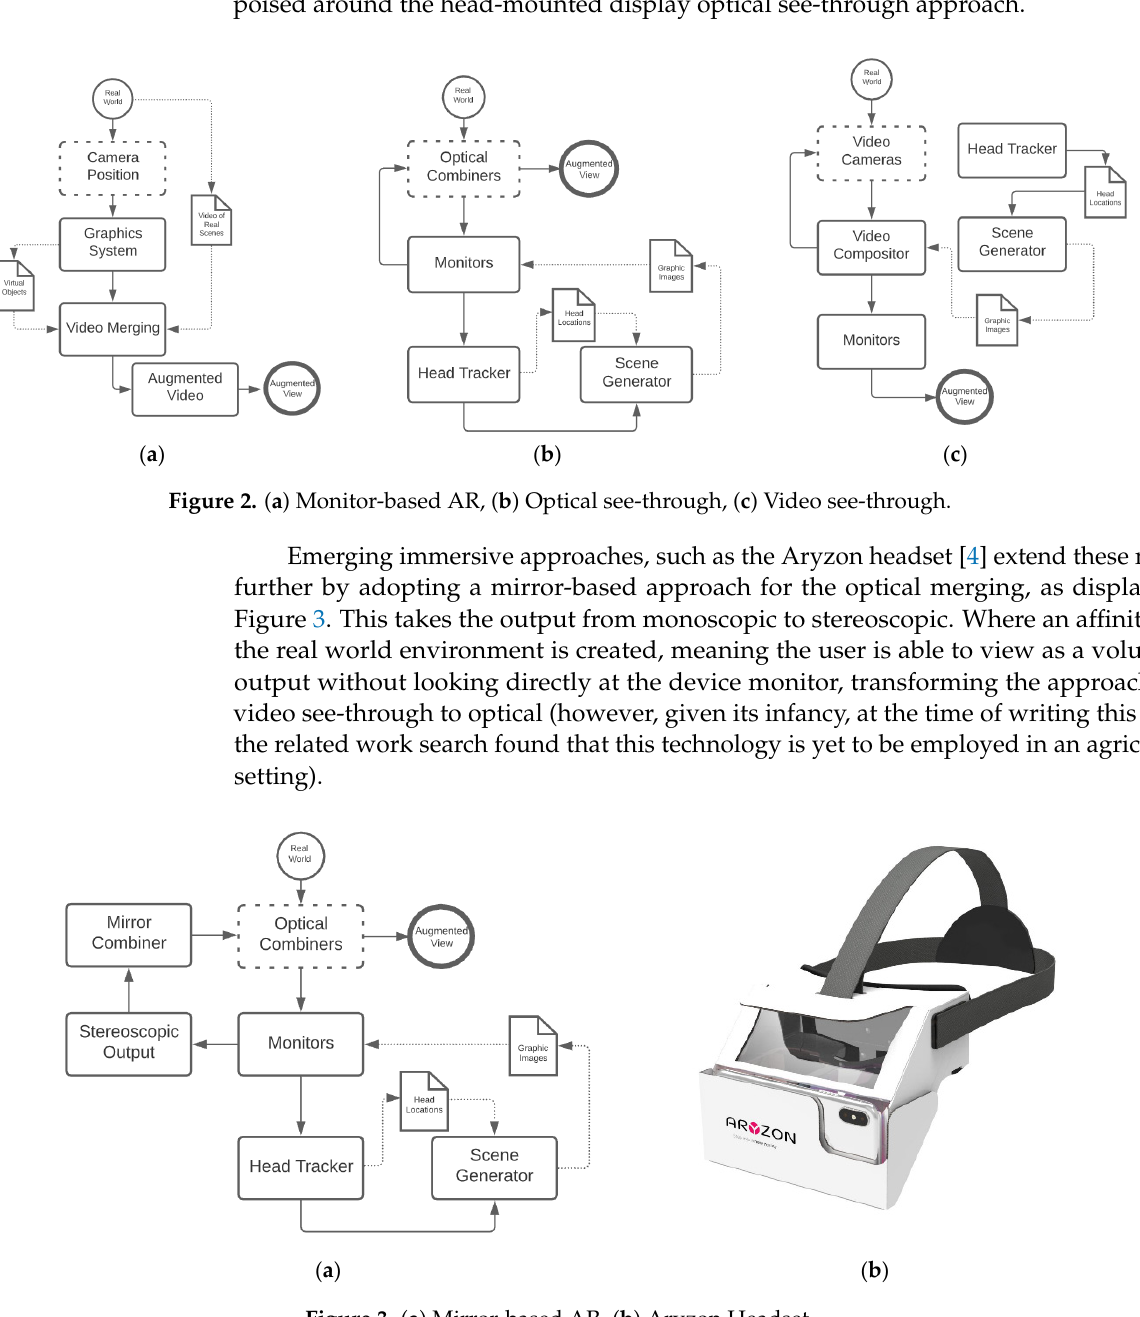
the screen. Whereas, optical see-through would be a projection in front of the user’s eyes combining video captured in real-time and coupled with the AR input. For example the OGD hardware used in [15] is poised around the head-mounted display optical see-through approach.